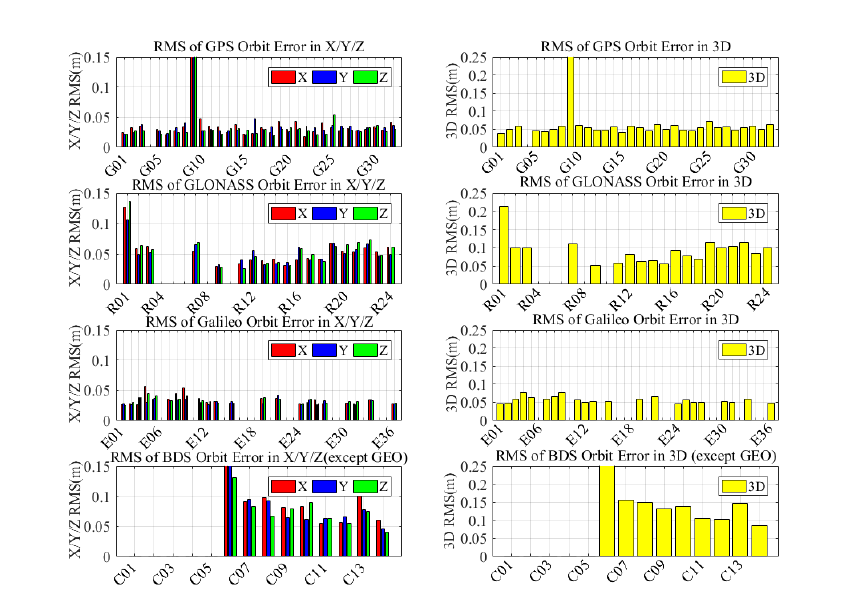
Figure 7. RMS values of CLK93 products’ orbits with reference to GFZ’s final products.